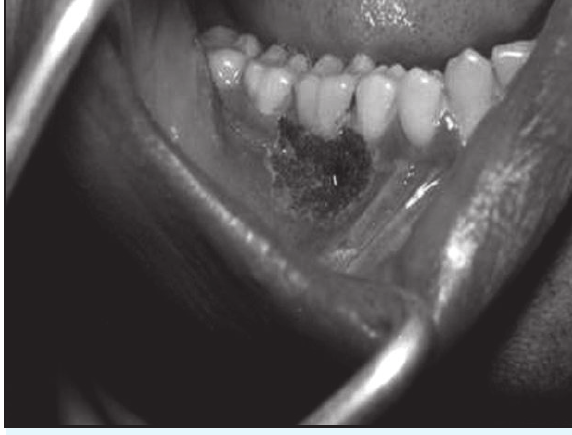
Figure 2a. Immediately after co2 laser surgery Figure 2b. After two weeks of co2 laser surgery